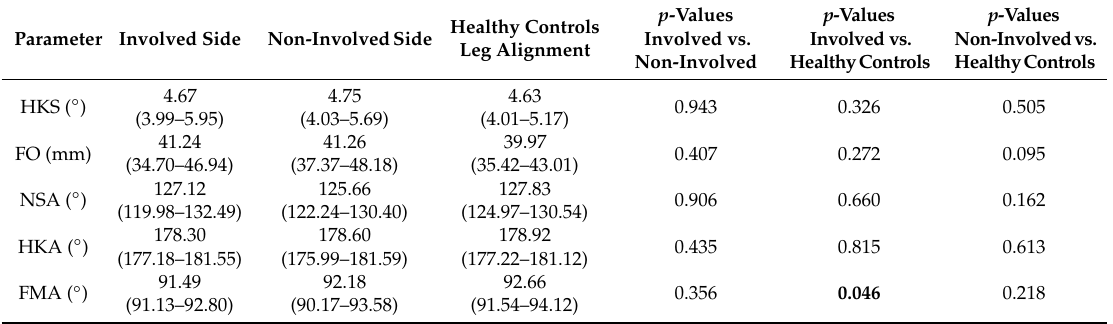
Values are represented as median values with the 25th and 75th percentiles. The significant difference is highlighted in bold. Abbreviations: HKS—hip–knee–shaft angle; FO—femoral offset; NSA—neck–shaft angle; HKA—hip–knee angle; FMA—femoral mechanical